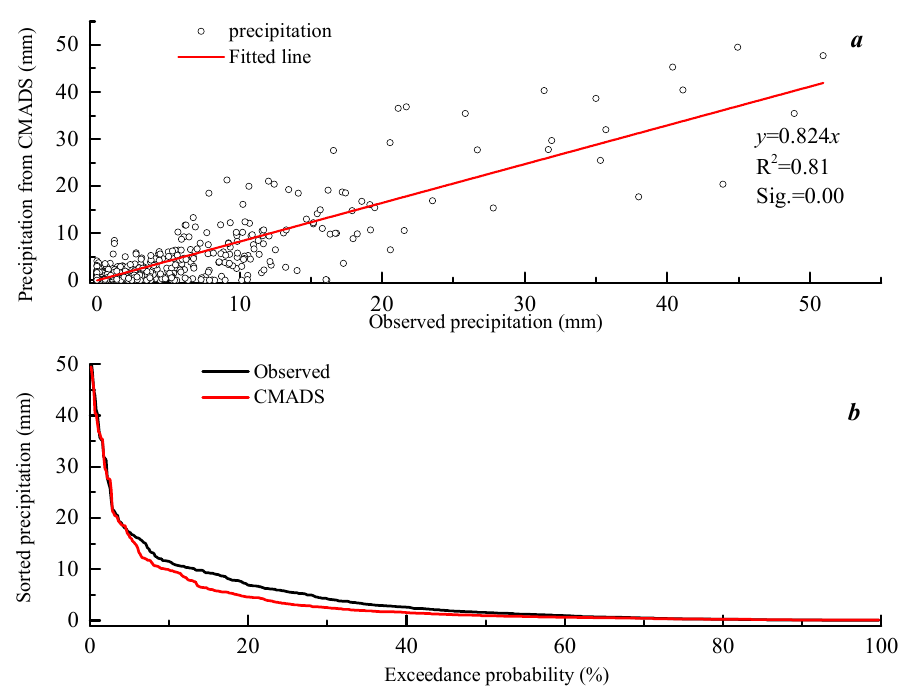
Figure 9. The evaluation of precipitation from CMADS. ( a ) A scattered plot of observed precipitation and CMADS precipitation; ( b ) the duration curve of observed precipitation and CMADS precipitation.